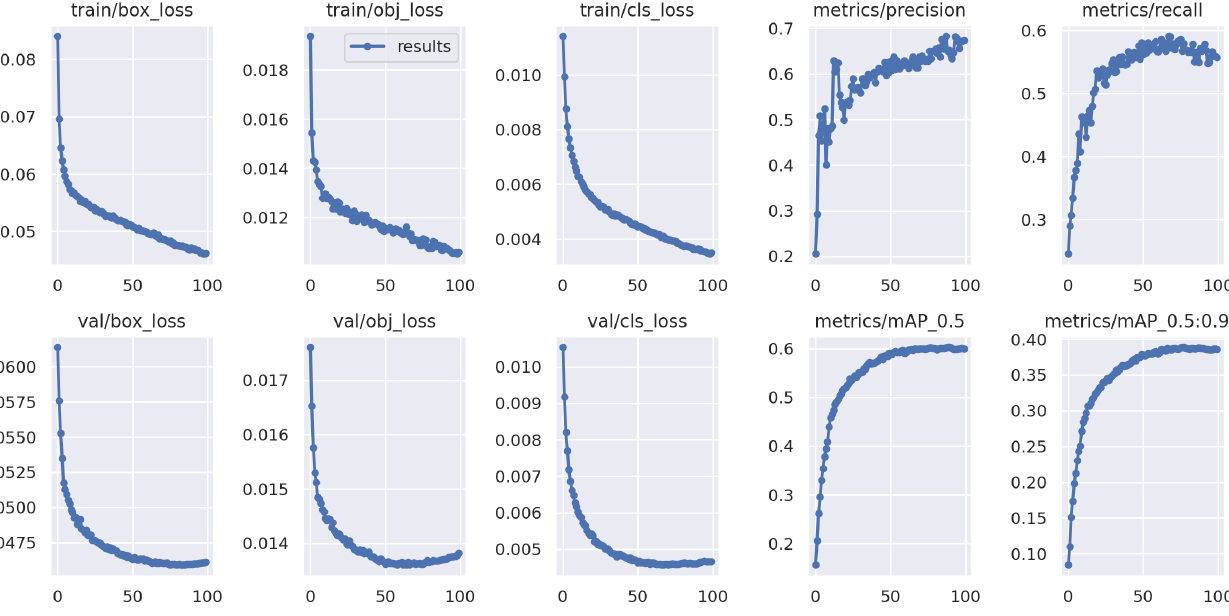
Figure 10. Visualization of various metrics (box loss, objective loss, class loss, precision, recall, mAP 0.5 , mAP 0.5:0.95 ) with the number of epochs during training and